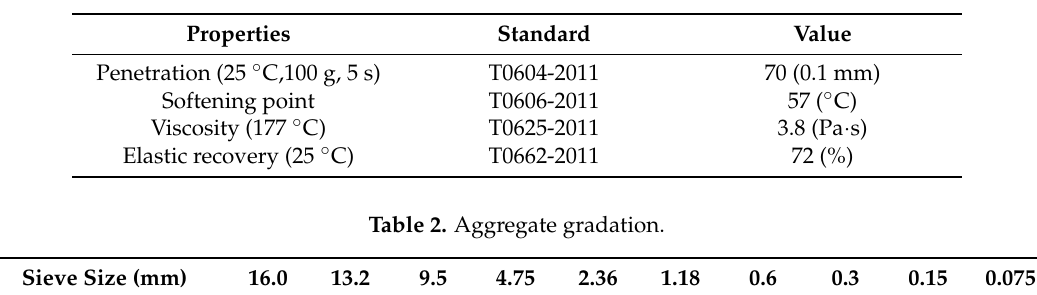
Table 1. Properties of asphalt rubber.